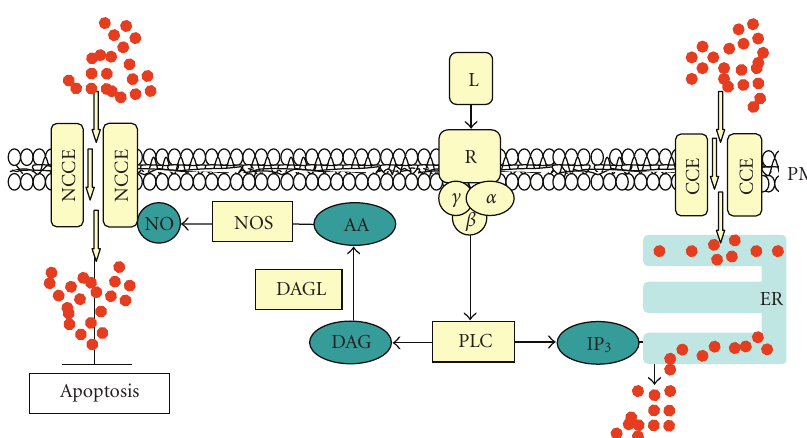
Figure 2: Capacitative and noncapacitative Ca 2+ entry. Ligand (L) stimulation of G-protein ( αβγ )-coupled receptor (R) activates phospholipase C (PLC) to produce diacylglycerol (DAG) and inositol-3-phosphate (IP 3 ). IP 3 (right side) causes ER Ca 2+ emptying, eliciting a capacitative Ca 2+ entry (CCE) through plasma membrane (PM), aimed at refilling ER of Ca 2+ restoring ER homeostasis. DAG (left side) is processed to arachidonic acid (AA) by DAG lipase (DAGL), stimulating NOS to produce NO, which activates Ca 2+ entry through PM by a noncapacitative Ca 2+ entry (NCCE), priming specific signaling including anti-apoptotic pathways. CCE and NCCE di ff er in protein composition [124]. Red dots symbolize Ca 2+